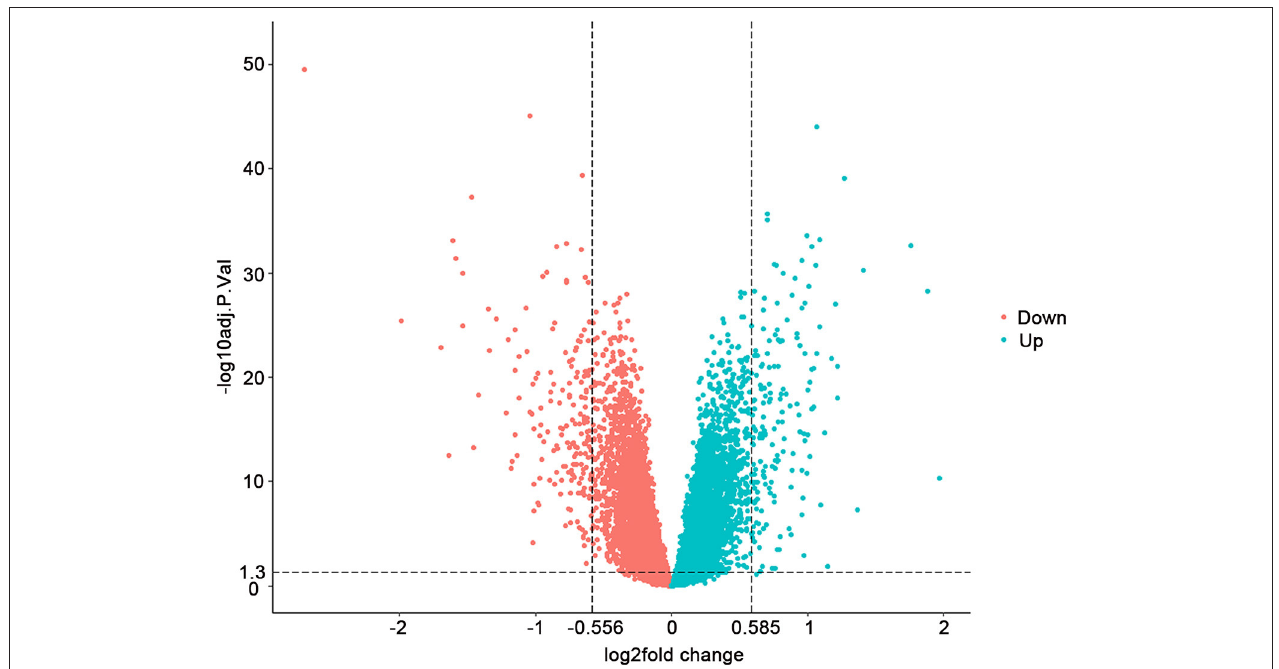
FIGURE 1 | Differential gene expression between 177 failing hearts and 136 healthy donor controls. Volcano plots depicting the extent (x-axis) and significance (y-axis) of differential gene expression between failing and healthy heart samples. Fold change represents failing vs. control hearts.